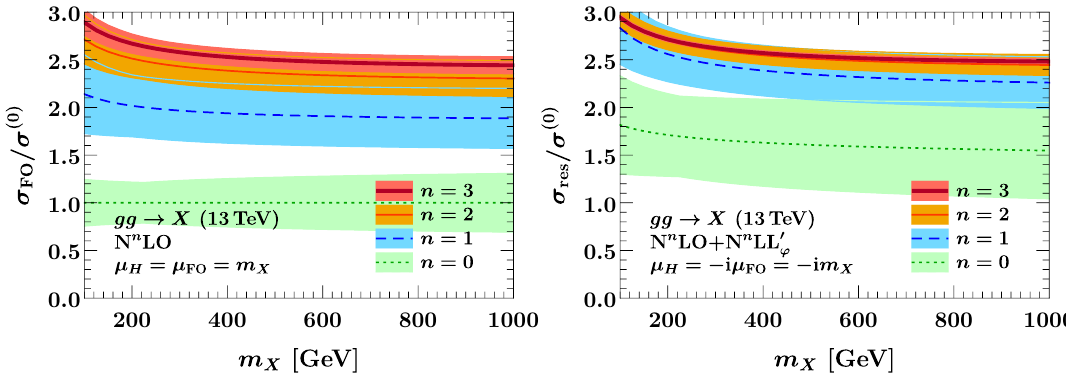
Figure 3 . The total cross section for gg ! X at E cm = 13 TeV at (cid:12)xed order (left) and including the resummation of timelike logarithms (right). All results are normalized to the central LO prediction at (cid:22) FO = m X